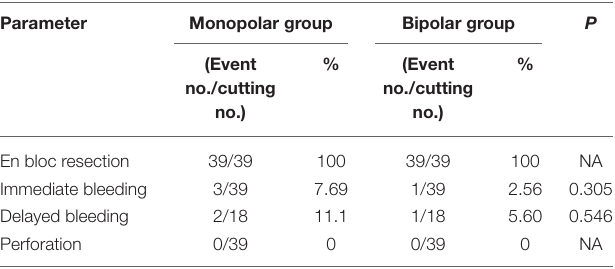
TABLE 1 | Ratio of en bloc resection, bleeding, and perforation in porcine experiment.